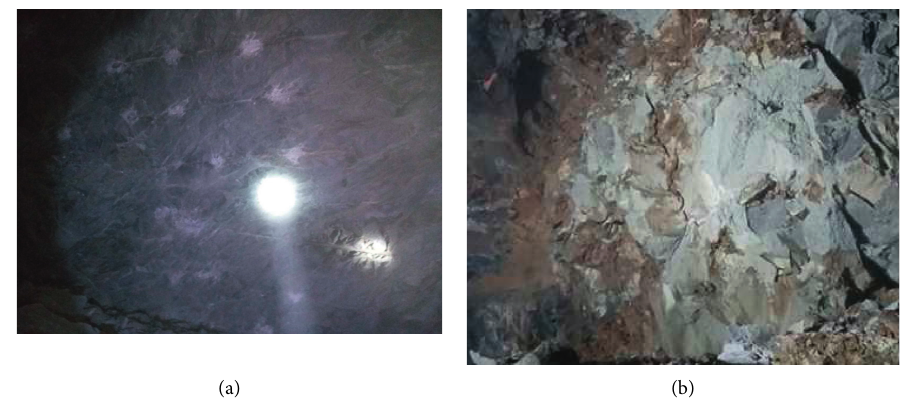
Figure 24: Surrounding rock condition after blasting: (a) shaped blasting and (b) ordinary